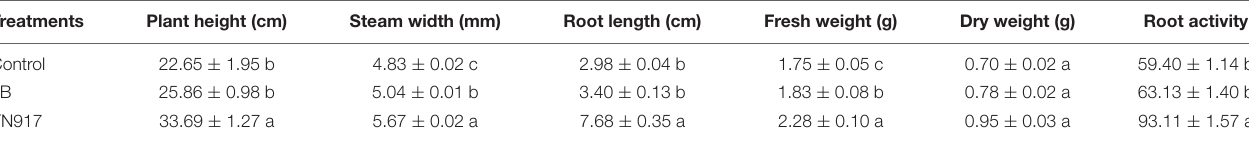
FIGURE 2 | Levels of IAA produced by B. cereus YN917 under shaking conditions. TABLE 2 | Growth parameters of rice plants noted 30 days after their inoculation with Bacillus cereus YN917 compared with control.